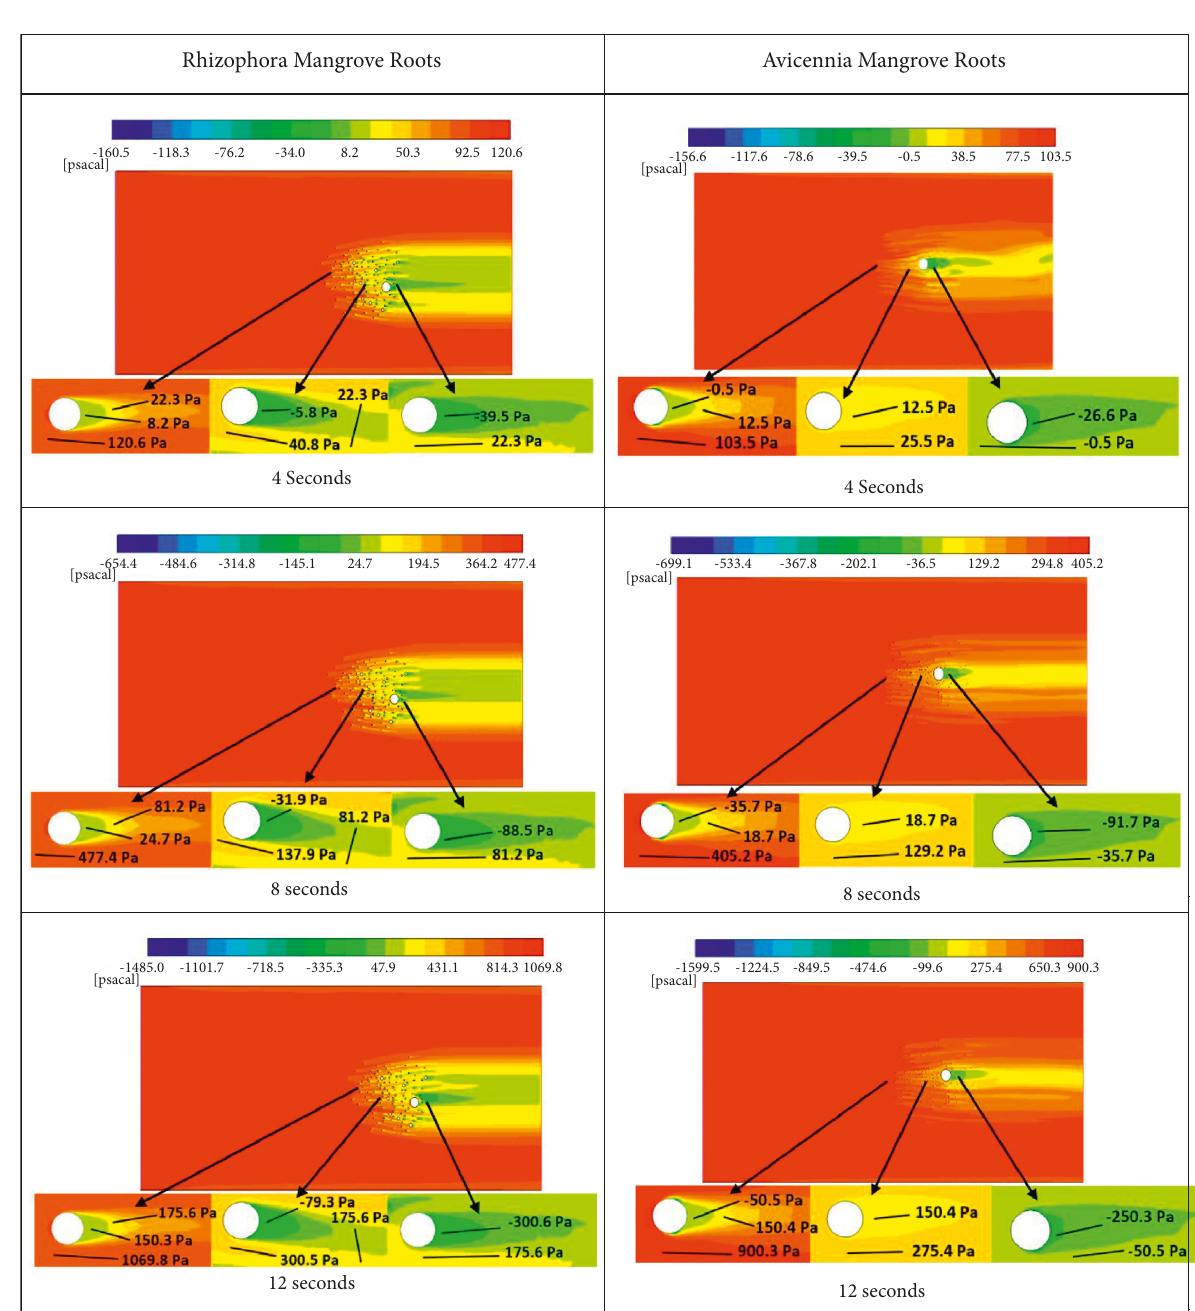
Figure 8: Pressure distribution of incompressible unsteady air flow at time intervals of 4 seconds, 8 seconds, and 12